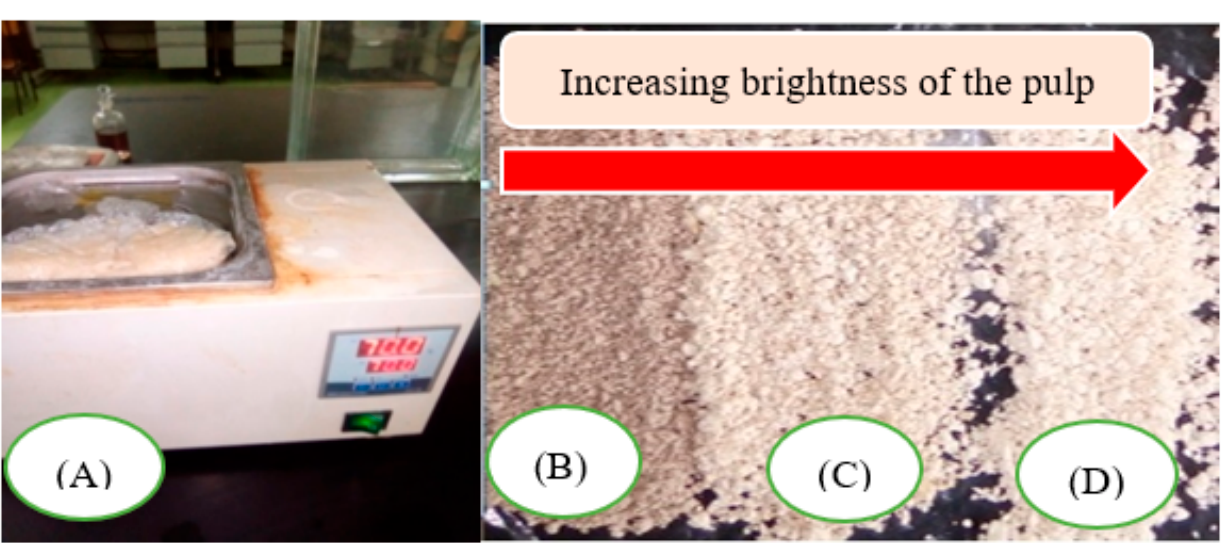
Figure 4. Pulp bleaching stage to determine the amount of lignin left and the amount of bleaching chemical: bleaching process takes place in a water bath ( A ), unbleached pulp ( B ), first stage bleaching ( C ), second stage bleaching ( D ). (Image taken by Megersa Bedo Megra )